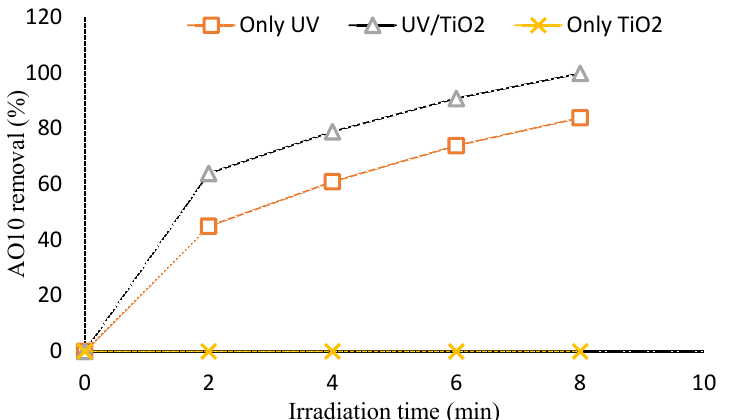
Fig. 7: Effect of TiO 2 on AO10 removal at different conditions as a function of irradiation time; [TiO 2 ] = 0.25 g/100 mL, dye concentration=10 mg/L, pH=3.5